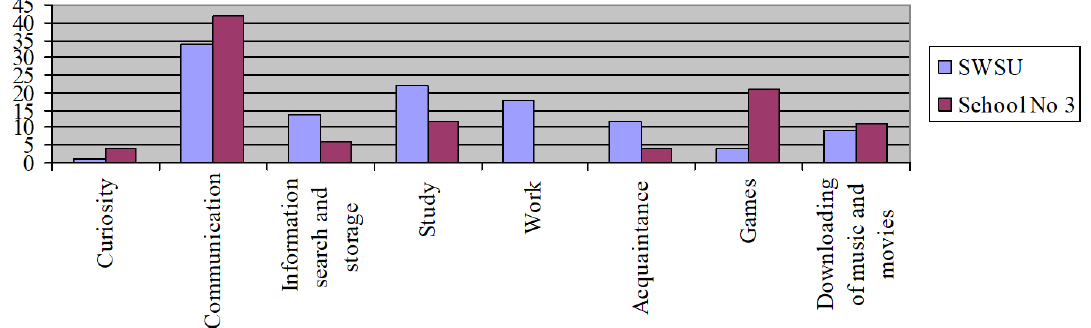
Figure 4 - Reasons for using different methods of